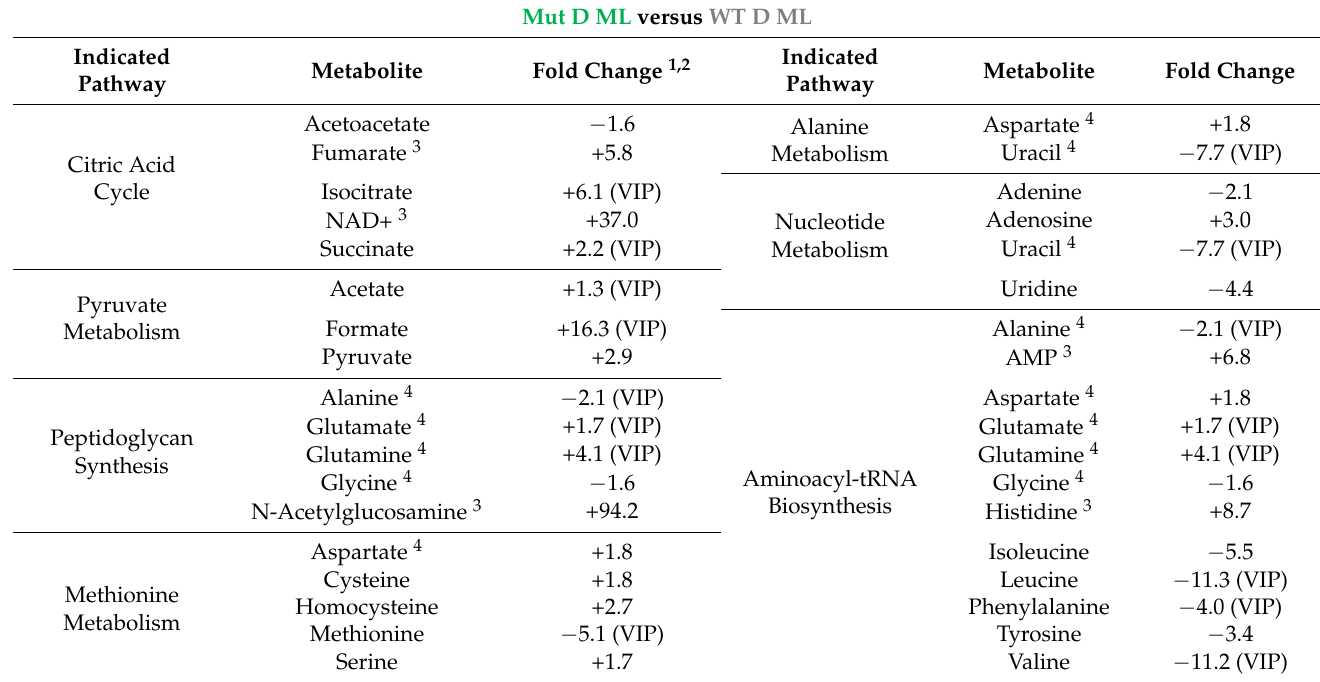
Table 3. Fold change of statistically significant metabolites in their corresponding metabolic pathways for the mid log phase of DABCOMD challenged mutant versus DABCOMD challenged wild type.